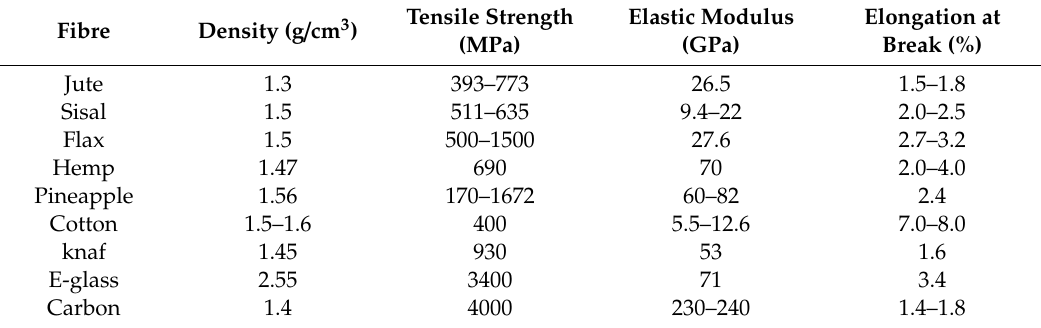
Table 2. Engineering properties of natural fibres